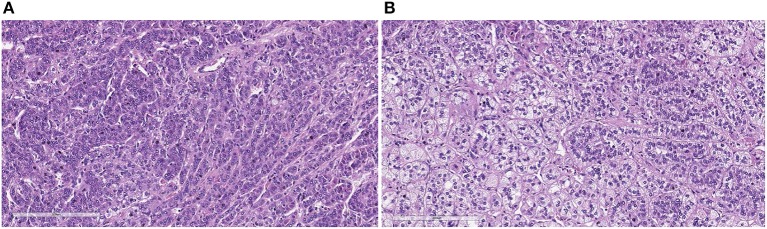
The histological sections show variable aspects, with areas with predominance of clear cells, vacuolated, with alveolar pattern (A) and others with predominance of compact cells with trabecular pattern (B) (H&E, X200).